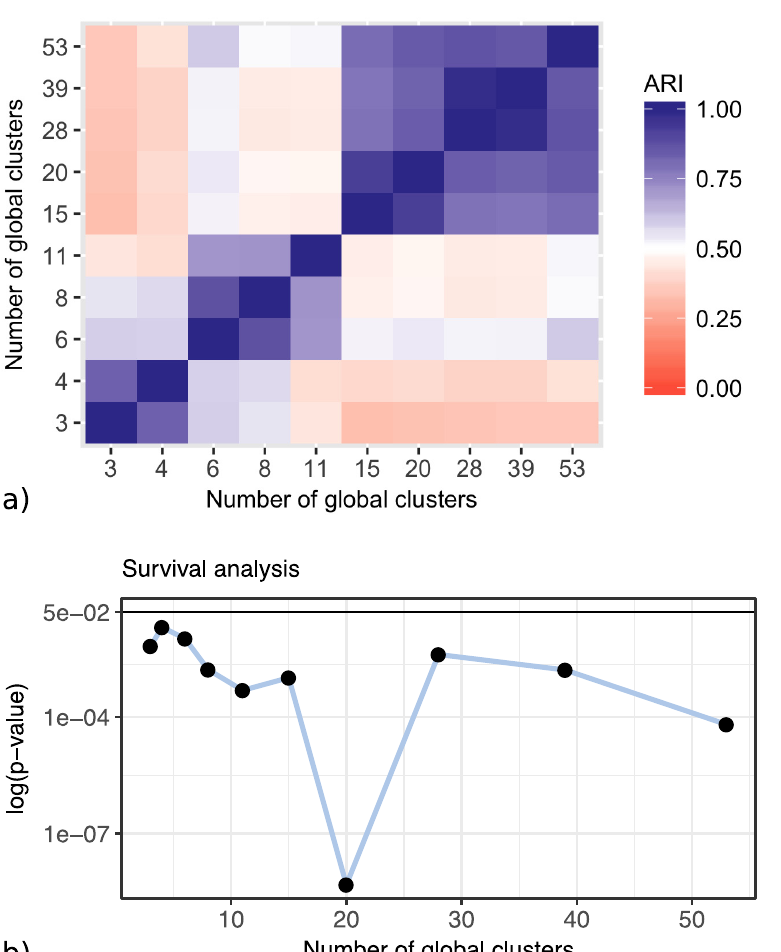
Fig 17. Consistency of results and survival p -values for clusters identified in the lung cancer dataset, with a range of numbers of global clusters and 3 local clusters. (a) Consistency of results with respect to the ARI betweendifferent settings of numbers of globalclusters. (b) p -values corresponding to the different numbers of globalclusters.